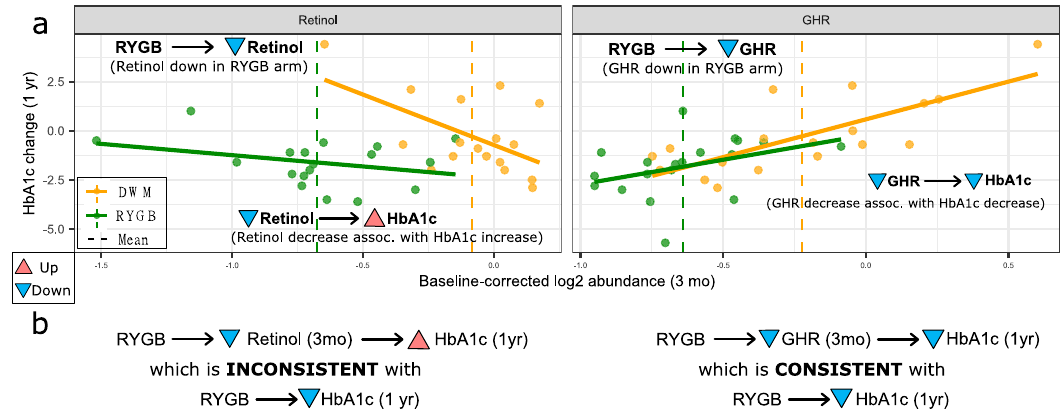
Fig. 6 GHR is a consistent mediator of change in HbA1c. Retinol is an inconsistent mediator (i.e., it suppresses or inhibits the causal effect; left side) whereas GHR is a consistent mediator of HbA1c change at 1 year (right side). a X -axis represents log 2 abundance change from baseline to the 3 month time point, and Y -axis represents HbA1c change from baseline at 1 year. b Shows putatively causal links with arrows based on (A) and direction of change with triangles pointed up (increase) or down (decrease). Source data are provided as a Source Data fi signi fi cance, consistent with our simulations demonstrating that Hitman offers signi fi cantly more power (Supplementary Note 1). The top-ranking analytes identi fi ed by the joint signi fi cance method were GHR ( p = 2.3 * 10 − 4 ; FDR = 0.26) and prolylhy- droxyproline ( p = 10 − 3 ; FDR = 0.73). Prolylhydroxyproline was